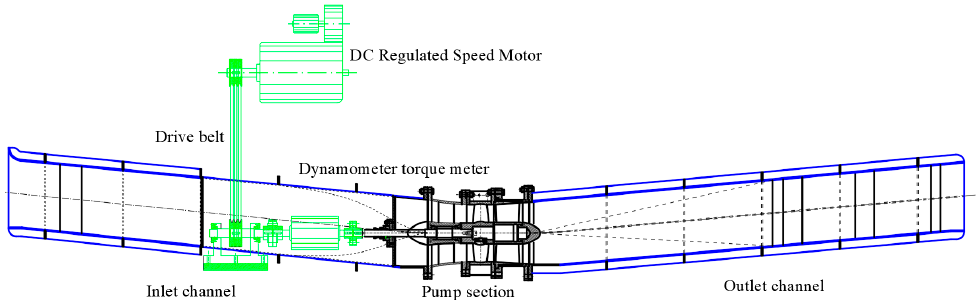
Figure 3. Test drive motor system.